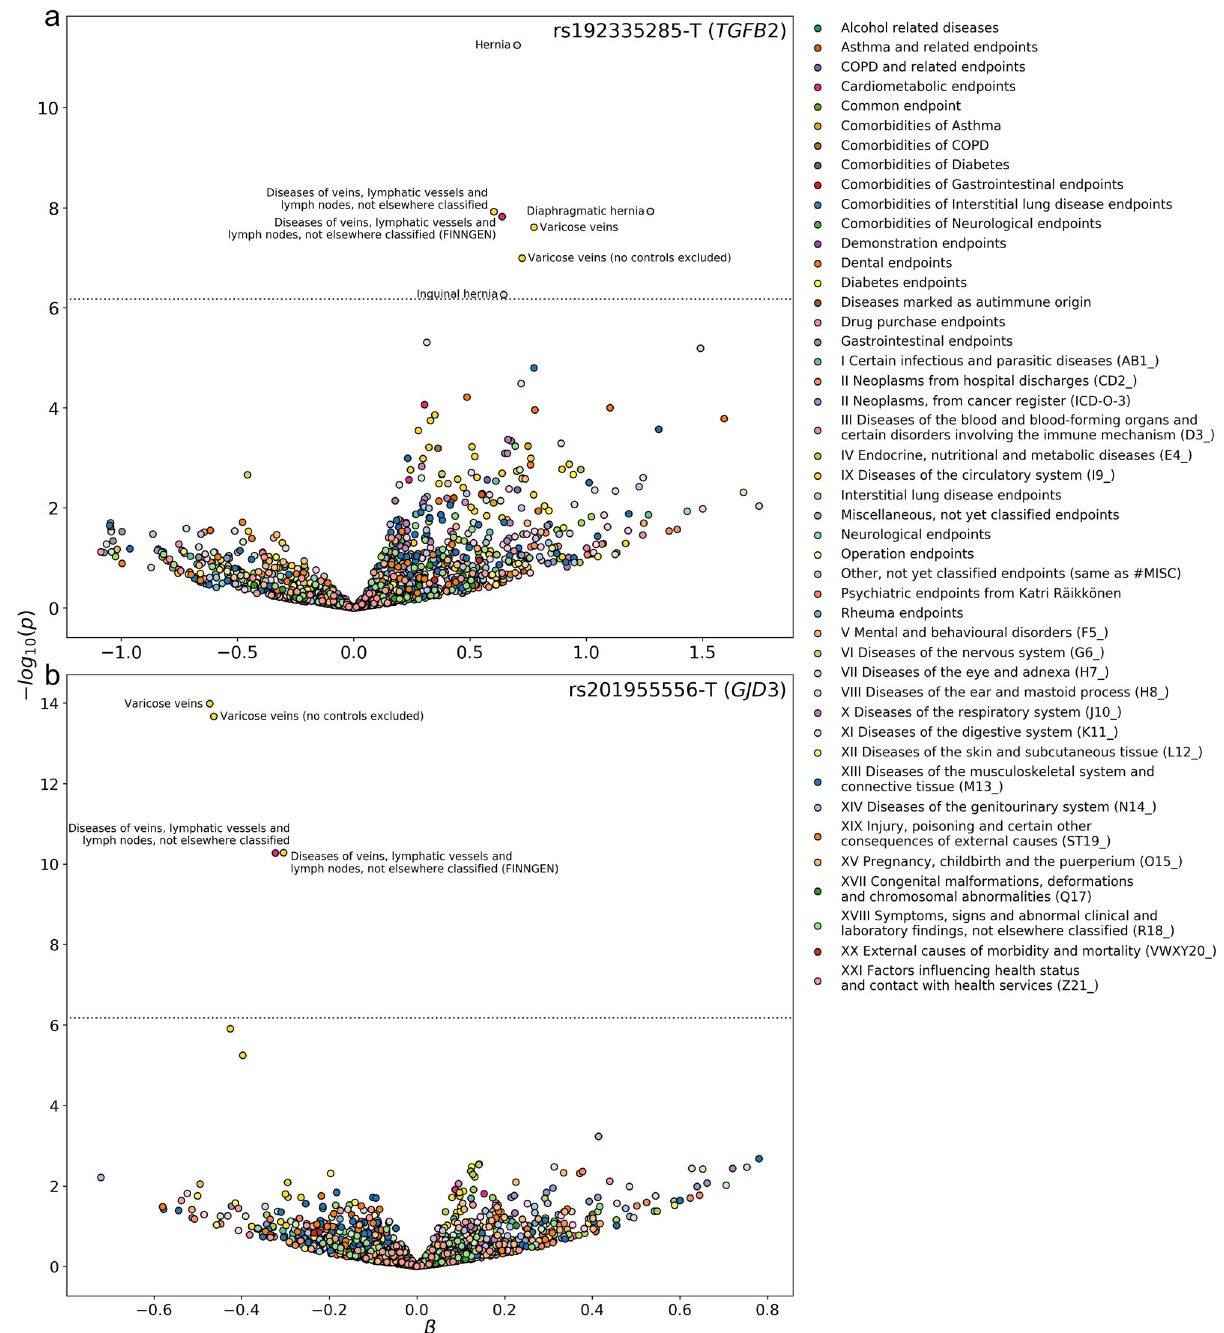
Fig. 3 TGFB2 and GJD3 locus zoom plots. The plot shows the VV associations for all analyzed variants within a 250 kb window around the lead variants of TGFB2 in a and GJD3 in b loci with − log P values along the vertical axis and the chromosome position along the horizontal axis. Genes 10 -transformed overlapping each locus are also displayed. Variants are colored by their LD value ( r 2 ) ranges calculated from the SISu v3 genome reference panel 69 in reference to the lead SNP in each region indicated by a purple